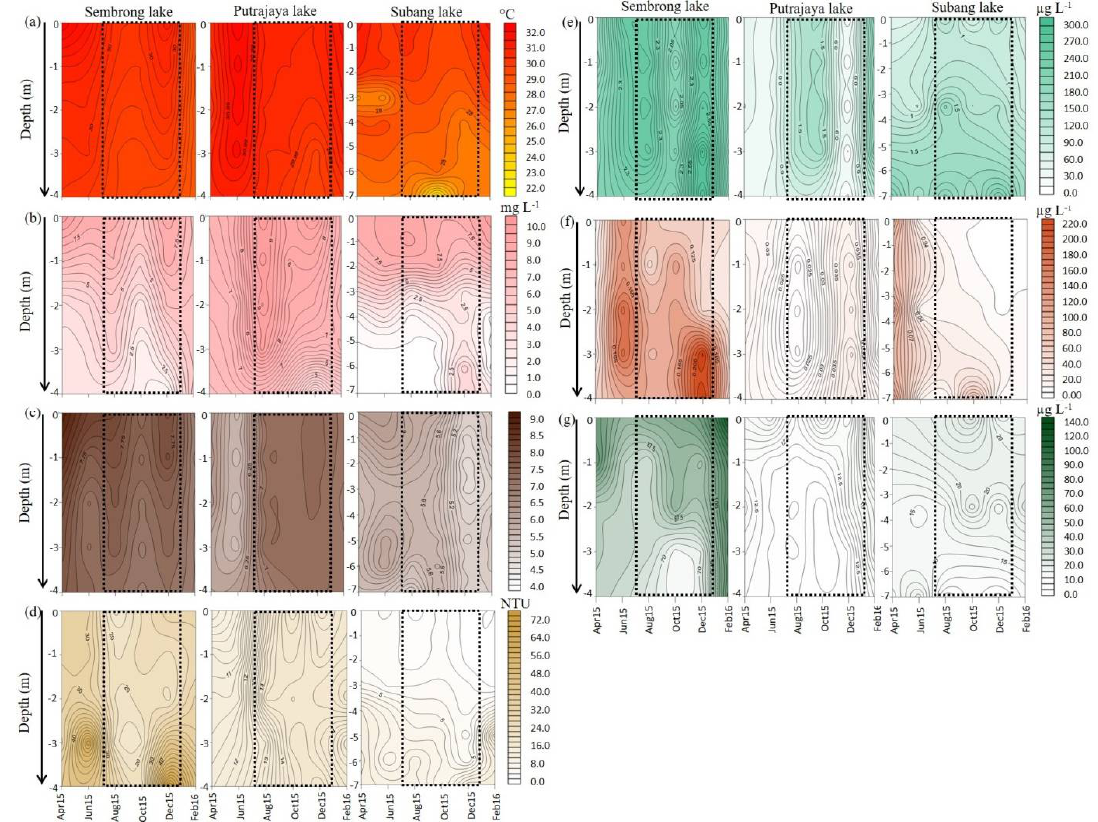
Figure 2. Vertical profiles of ( a ) water temperature, ( b ) dissolved oxygen, ( c ) pH, ( d ) turbidity, ( e ) total nitrogen, ( f ) total phosphorus and ( g ) chlorophyll a in different lakes. Arrows represent water depth (m) of lakes. Rectangular boxes indicate months with high rainfall (wet season).